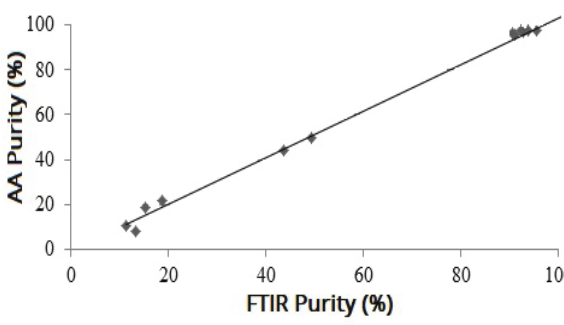
Figure 5 : Correlation between FTIR and AA purity results.